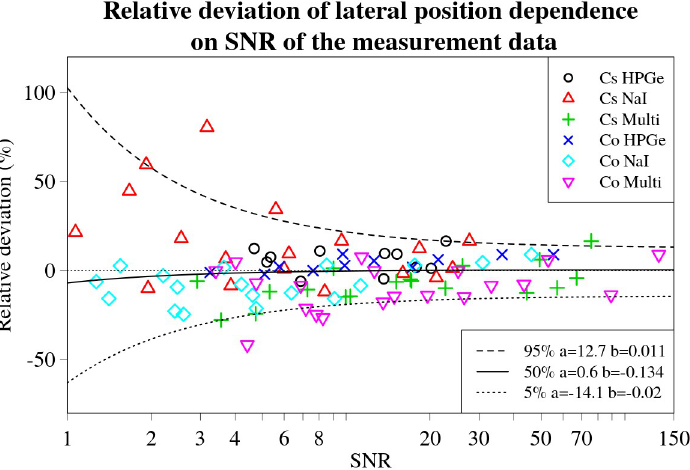
Fig 16. Lateral position relative deviation values for every experimental set-up, detector and source combination plotted against the respective SNR values. Black dashed line denotes the 5%, solid line—50% and dotted line—95% (from top to bottom) curves denoting corresponding quantile dependencies on SNR of the data, obtained using non- linear quantile regression. Fitted parameters a and b of the lines are displayed in a legend on the right.